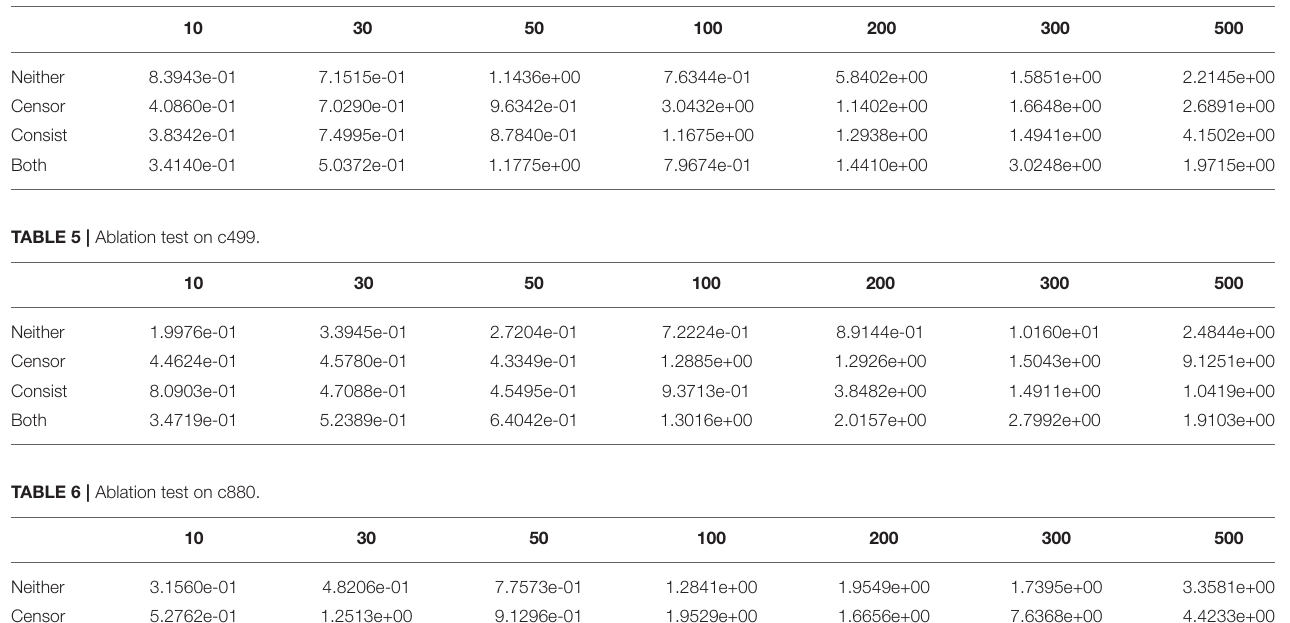
TABLE 4 | Ablation test on c432.